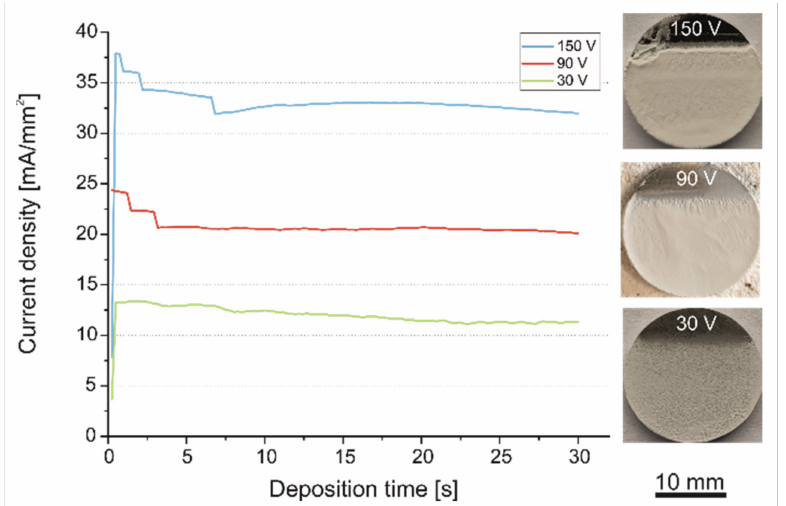
Figure 7. Current density variation for the EPD of n-HA/ZnS/PEEK coatings with macroscopic images of as-deposited coatings for the corresponding